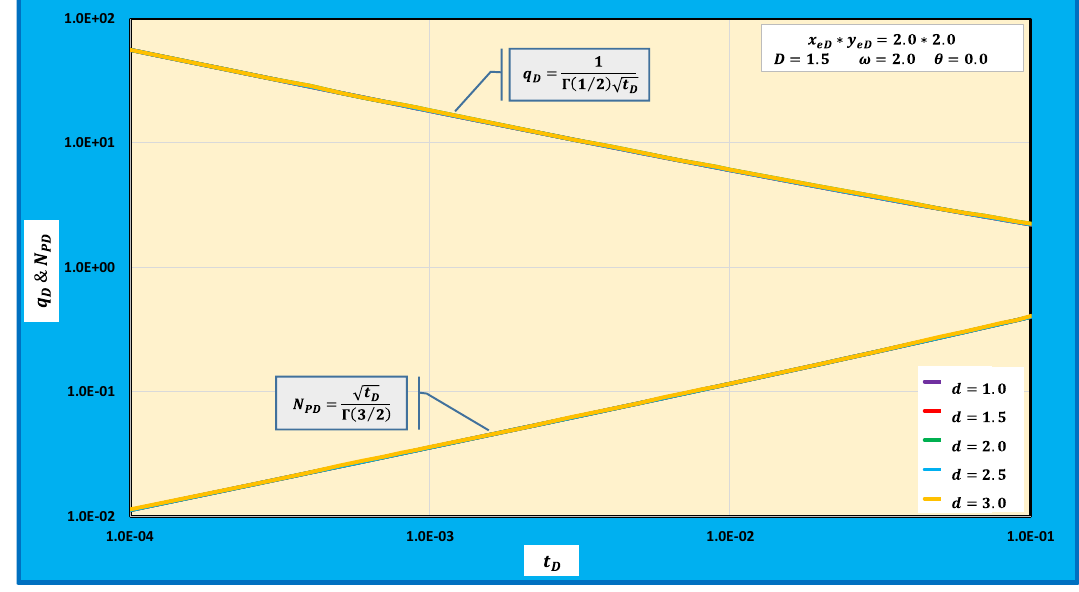
Fig. 20 Flow rate and cumulative production of hydraulic fracture linear flow